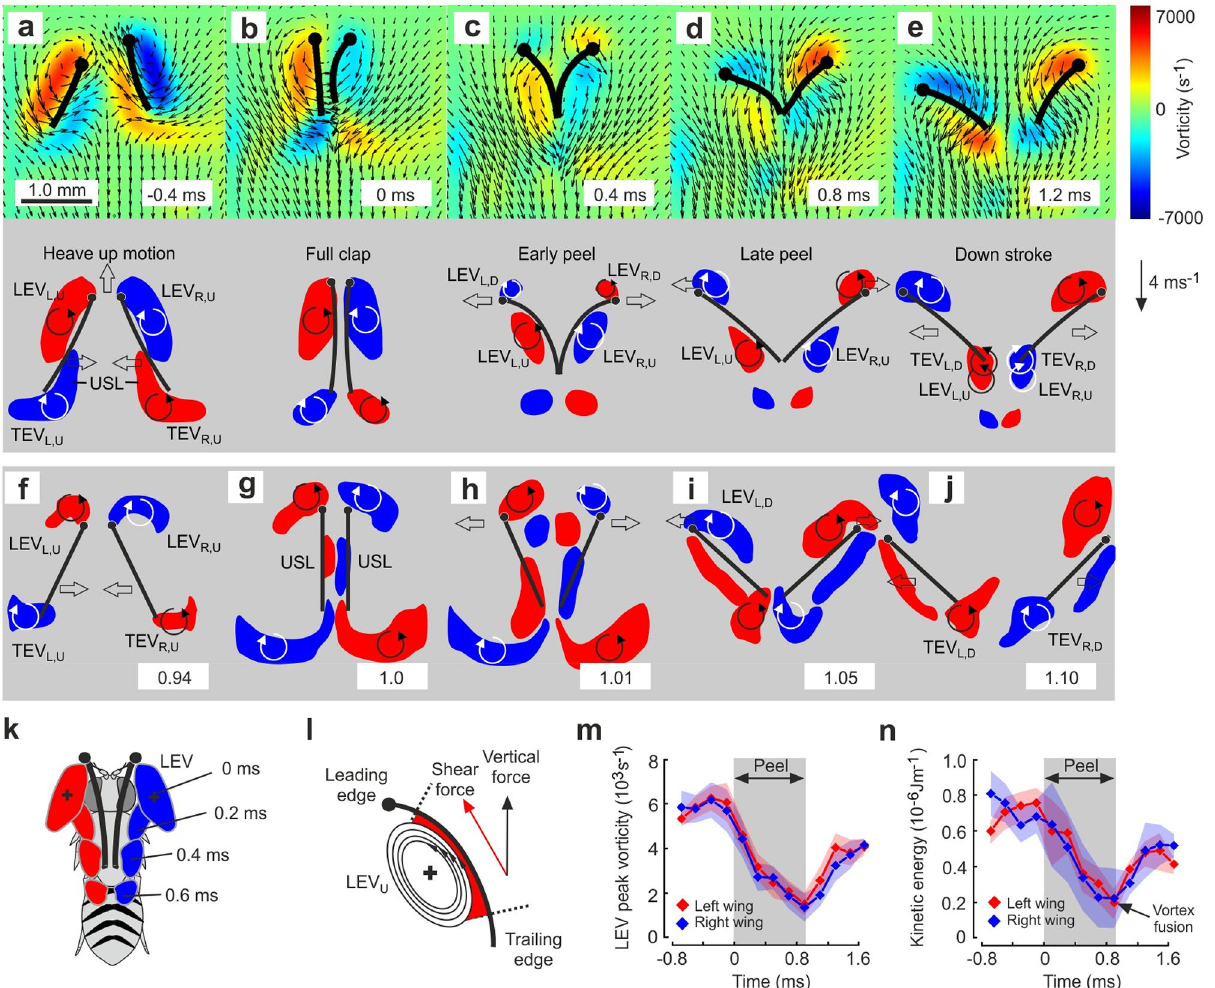
Figure 2. Fluid vorticity, LEV travelling and depletion of vorticity and kinetic energy. (a–e ) Images show fluid vorticity (upper row) and vortex reconstruction (lower row) at 5 out of 17 measured times (10 kHz sampling rate) during clap-peel-fling in a single wing stroke cycle. Black lines highlight chordwise deformation of left and right wing blade at 0.6 wing length with the wing’s leading edges (solid circle) pointing upward. LEV leading edge vortex; TEV trailing edge vortex; USL undershear layer; L left wing; R right wing; U wing upstroke; D wing downstroke. Clockwise and anti-clockwise circulation is shown in blue and red, respectively. Vortices from the upstroke are completely shed during the dorsal stroke reversal. At the beginning of the downstroke, the leading edge vortex from the upstroke fuses with the trailing edge vortex that forms at the beginning of the downstroke. Vortices in the lower row were reconstructed from 15 stroke cycles and wing sections at 0.6 wing length. ( f–j ) Vortex reconstruction at 0.65 wing length in rigid robotic wings mimicking clap-and-fling in fruit fly wing kinematics. Timing is shown in fraction of the stroke cycle (1). Flapping frequency was ~ 0.17 Hz and Re = ~ 180. Data are replotted from a previous study 28 . ( k ) Reconstruction of leading edge vortex shape and chordwise travelling during dorsal stroke reversal after clapping (0 ms). ( l ) Sketch of hypothesized momentum transfer of rotational energy (enstrophy) to the close-by surface by friction between leading edge vortex and wing surface. The horizontal wing stroke plane in fruit flies during hovering flight favours frictional forces in a vertical direction, supporting lift and nose-down pitching moments. ( m–n ) Depletion of peak vorticity and chordwise sectional energy of the leading edge vortex within ~ 1.0 ms after wing clapping (0 ms). LEV from the upstroke is shed after wing clapping and regains strength by fusion with the trailing edge vortex ~ 0.8 ms after the stroke reversal. Vortex decay time of a shed trailing edge vortex is shown in supplementary text S2. Data are means from 90 stroke cycles recorded in 6 animals and shaded areas indicate standard The fate of vortical structures at the end of the wings’ upstroke is key for aerodynamic recapture mechanisms (movie S1). Figure 2 shows the evolution of leading and trailing edge vortices during the dorsal stroke reversal in 5 equally-spaced out of 17 moments sampled at 10 kHz. At the beginning of wing rotation, vorticity of LEV at the ventral wing surface increases due to the wing’s increasing angle of attack. As a consequence of wing rota- tion and wing deceleration, the wing also produces counter-balancing vorticity at the trailing edge (Fig. 2a). At wing clapping, both vortices have gained maximum strength but remain attached at the ventral wing surface